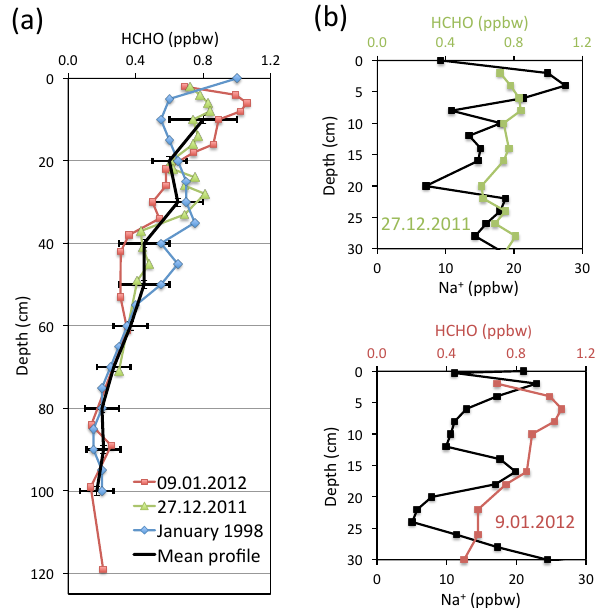
Figure 4. (a) Vertical profiles of HCHO in bulk snow at Concordia. The vertical snow profiles of HCHO obtained from the two snow pits dug during the 2011/12 campaign are compared to those from a snow pit dug in January 1998 (Hutterli et al., 2002). (b) Sodium versus HCHO content in the upper 30cm of the two snow pits dug in 2011/12.